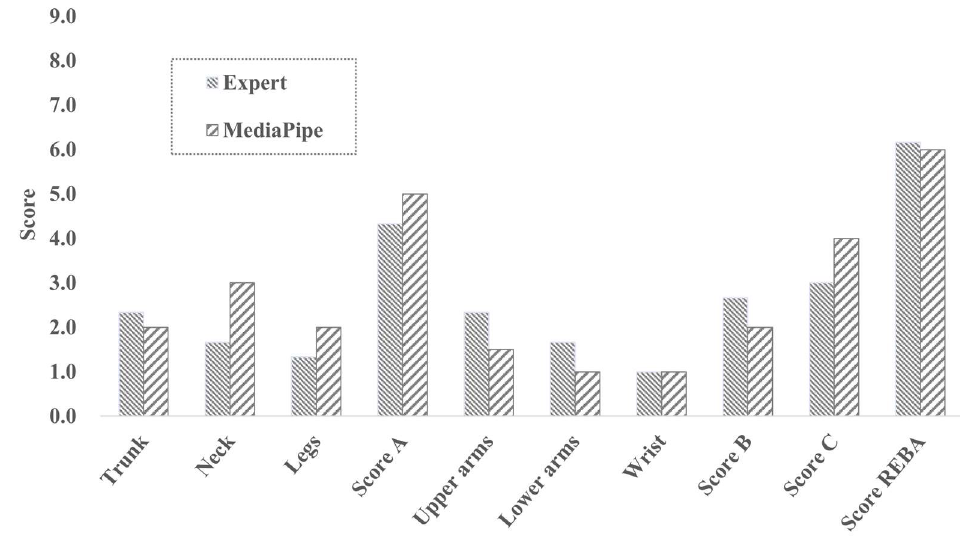
Figure 40. Comparison of planer working posture scores.